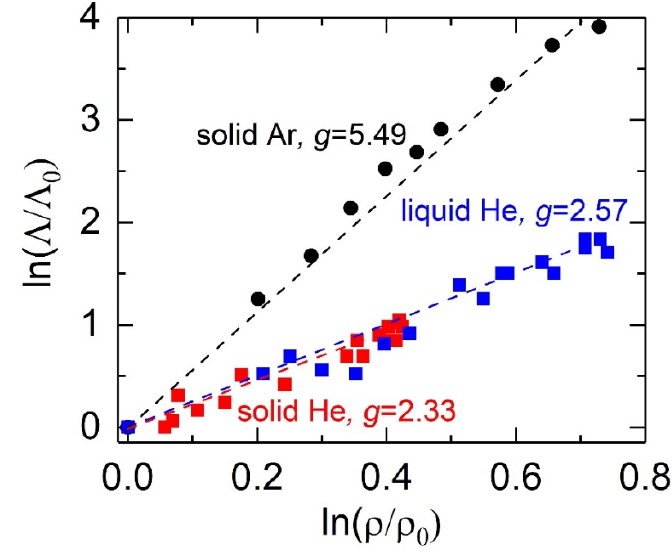
Figure 3. Logarithmic normalized thermal conductivity as a function of logarithmic normalized density for liquid He, solid He, and solid Ar. The blue, red, and black symbols are the present results for liquid He, solid He, and solid Ar, respectively. The dashed line for each set of data is a linear fit with a slope ( g ) of 2.57(±0.15) (liquid He), 2.33(±0.15) (solid He), and 5.49(±0.2) (solid Ar).